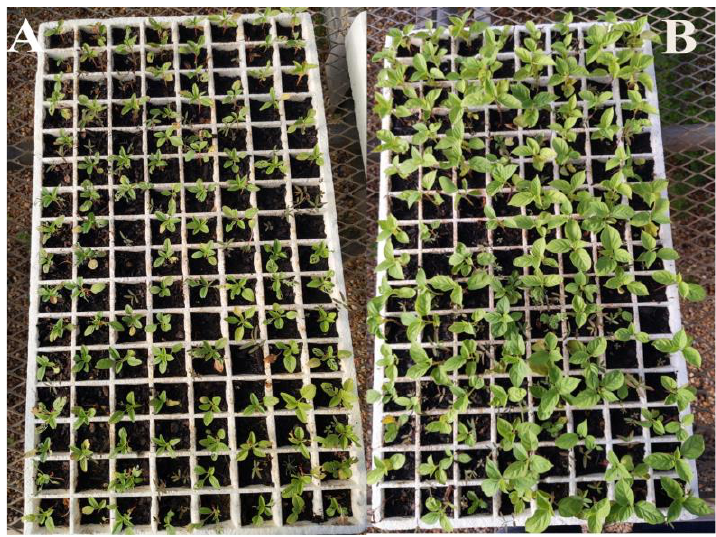
Figure 3. Collected weeds in the pots in greenhouse before treatment. Small flower morningglory ( A ), and Palmer Amaranth ( B ).